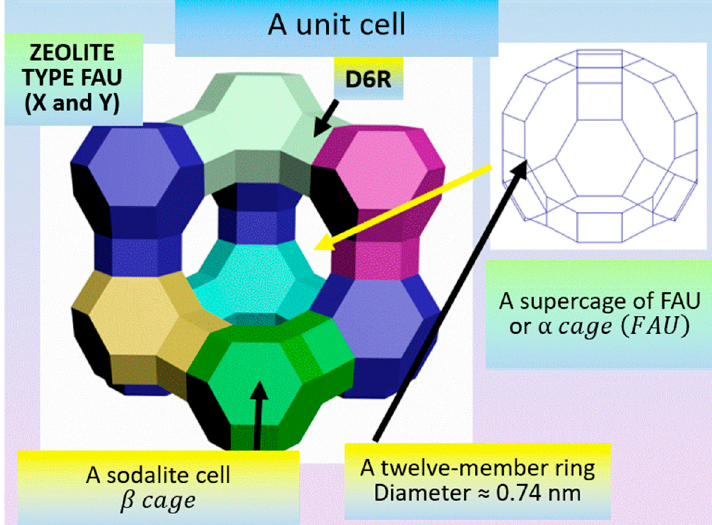
Figure 11. Type FAU sodalite unit cell [compiled by the authors].